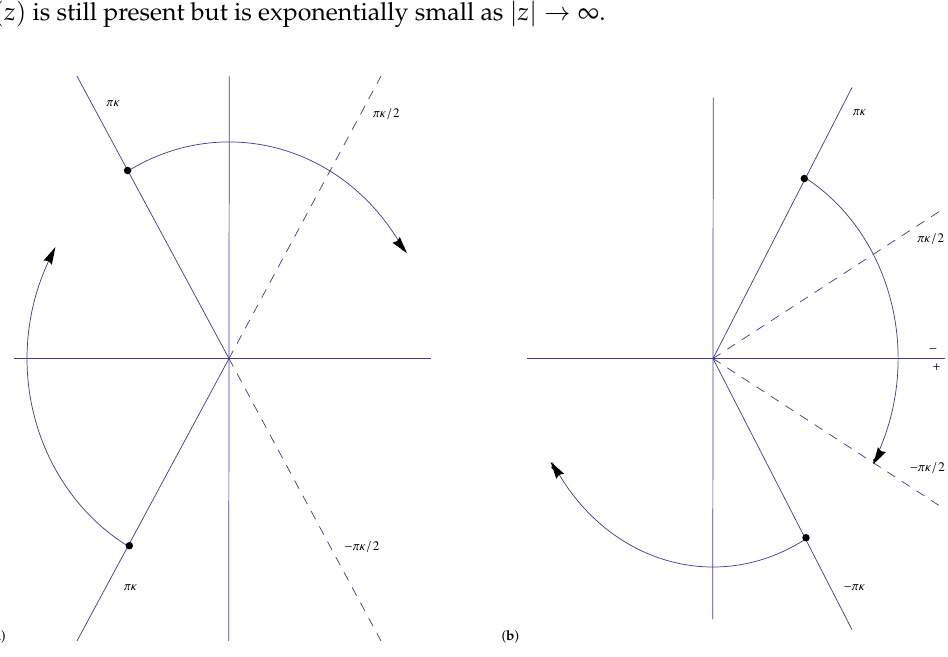
πκ and the boundaries of the exponentially large ± < 1 < σ < 1. The πκ , κ = 1 σ for ( a ) 0 < σ < 1 arg z and ( b ) 1 2 2 2 | | − πκ ω r for 0 1 with r N ± − ≤ ≤ − signs in ( b ) denote the signs to be chosen in H ( z ) on ±